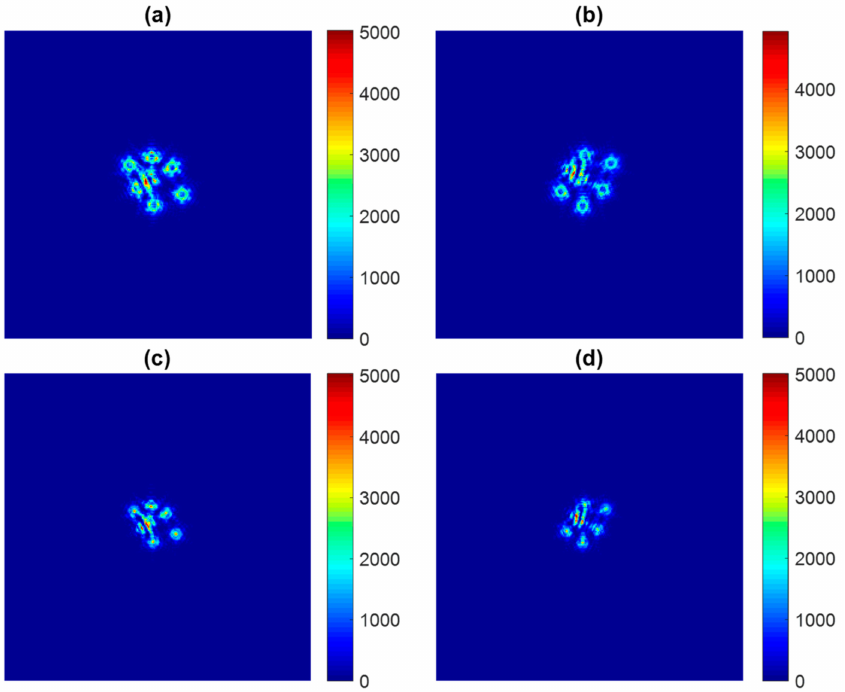
Figure 5. Simulated images taken from defocus planes: ( a ) defocus at − 71.75 mm, ( b ) defocus at 71.75 mm, ( c ) defocus at − 53.81 mm, and ( d ) defocus at 53.81 mm. The minus symbol means defocusing along light-traveling